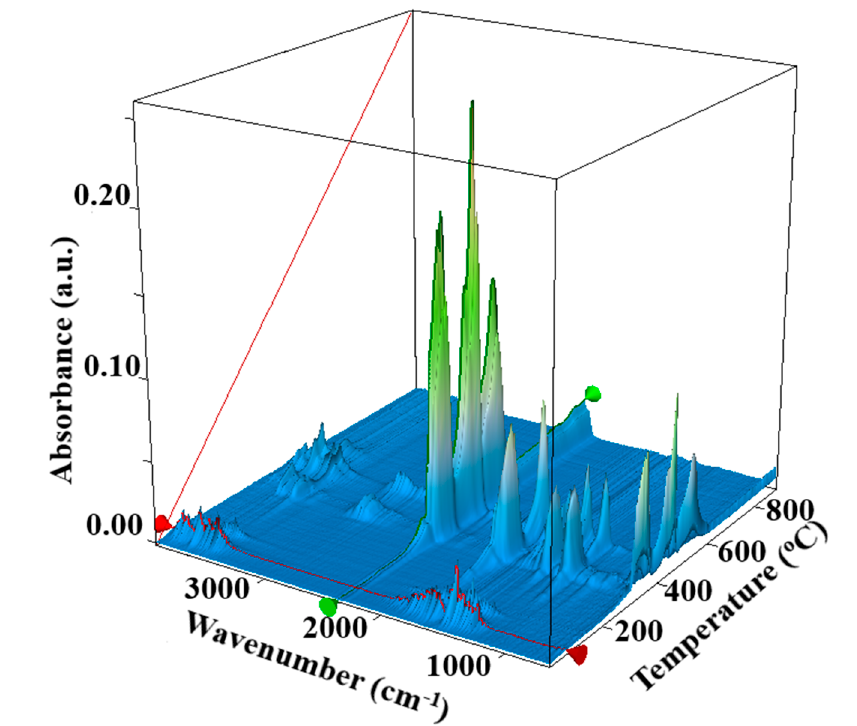
Figure 1. Thermal analysis of ZnO powder.